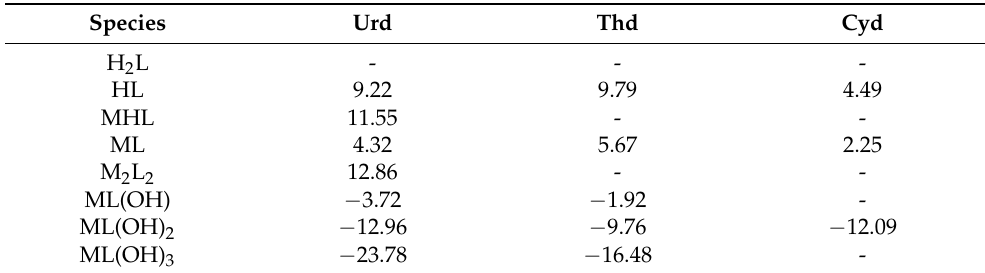
Table 3. Protonation and stability constants for complexes in the Cu(II)/Nuc systems (Standard deviation is given in parenthesis) [35].